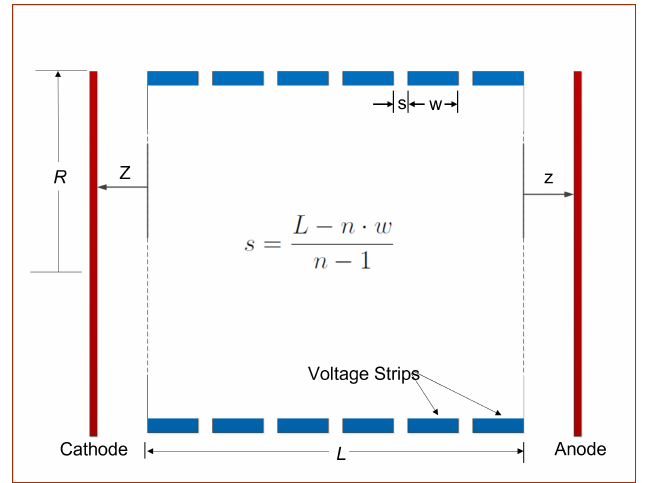
Figure 11. Model for the elimination of transverse fields and variations in the field E z